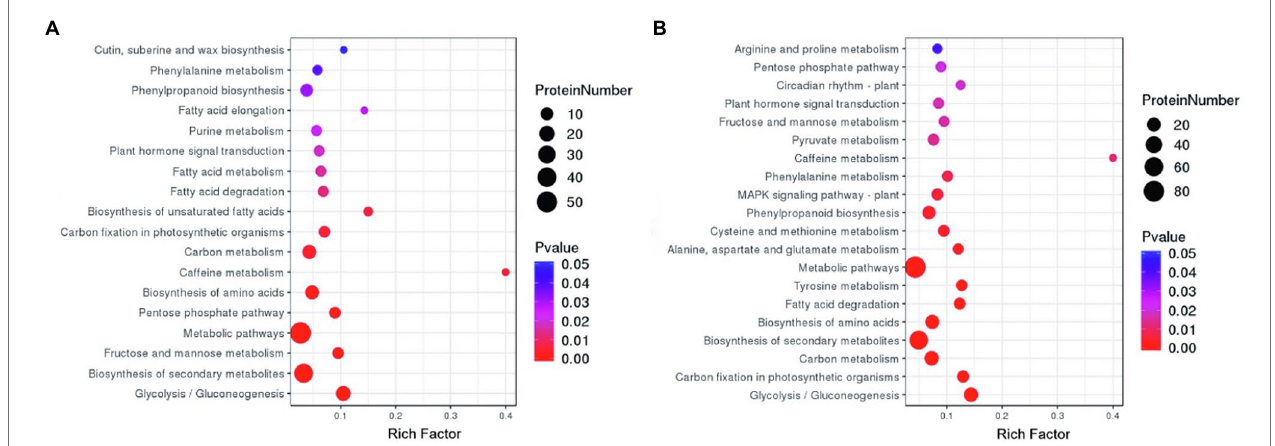
FIGURE 5 | The KEGG signaling pathways of DAPs in two different peanut cultivars were enriched by a bubble map after 12 days of waterlogging treatment. (A) Bubble map of the significantly enriched KEGG pathways of DAPs in ZH4 and its controls after 12 days of waterlogging treatment. (B) Bubble map of DAPs in KEGG pathways between XH08 and its control samples after 12 days of waterlogging